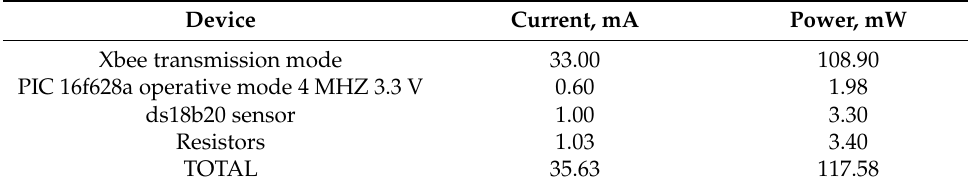
Table 1. Devices’ current and power consumptions.